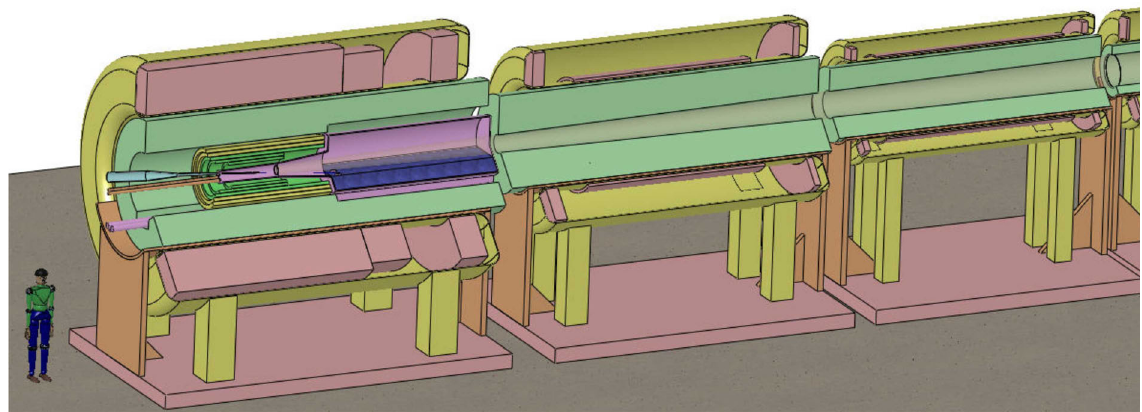
FIG. 5. Schematic of the EURO ν baseline Neutrino Factory target station using a free flowing mercury jet and capture